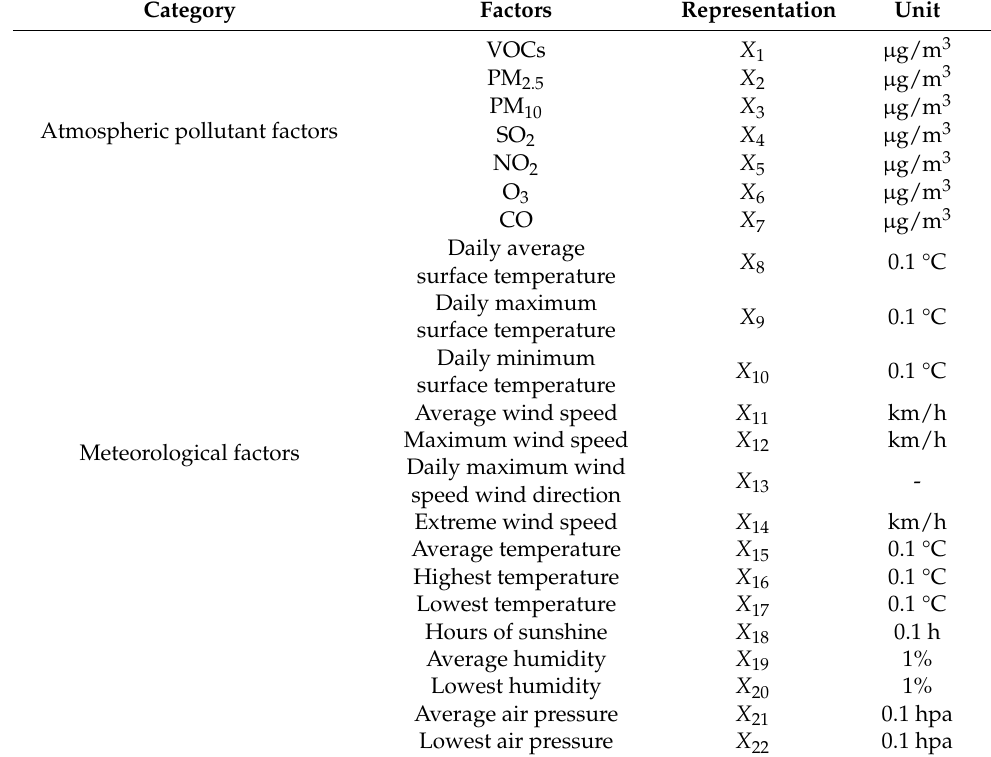
Table 3. Air pollutant and meteorological factors of VOCs aggregation sensing model. Category Factors